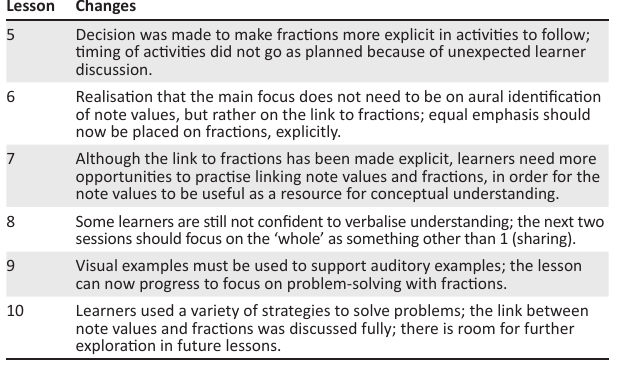
TABLE 2: Example changes and adaptations made through the cycles of reflection. Lesson Changes